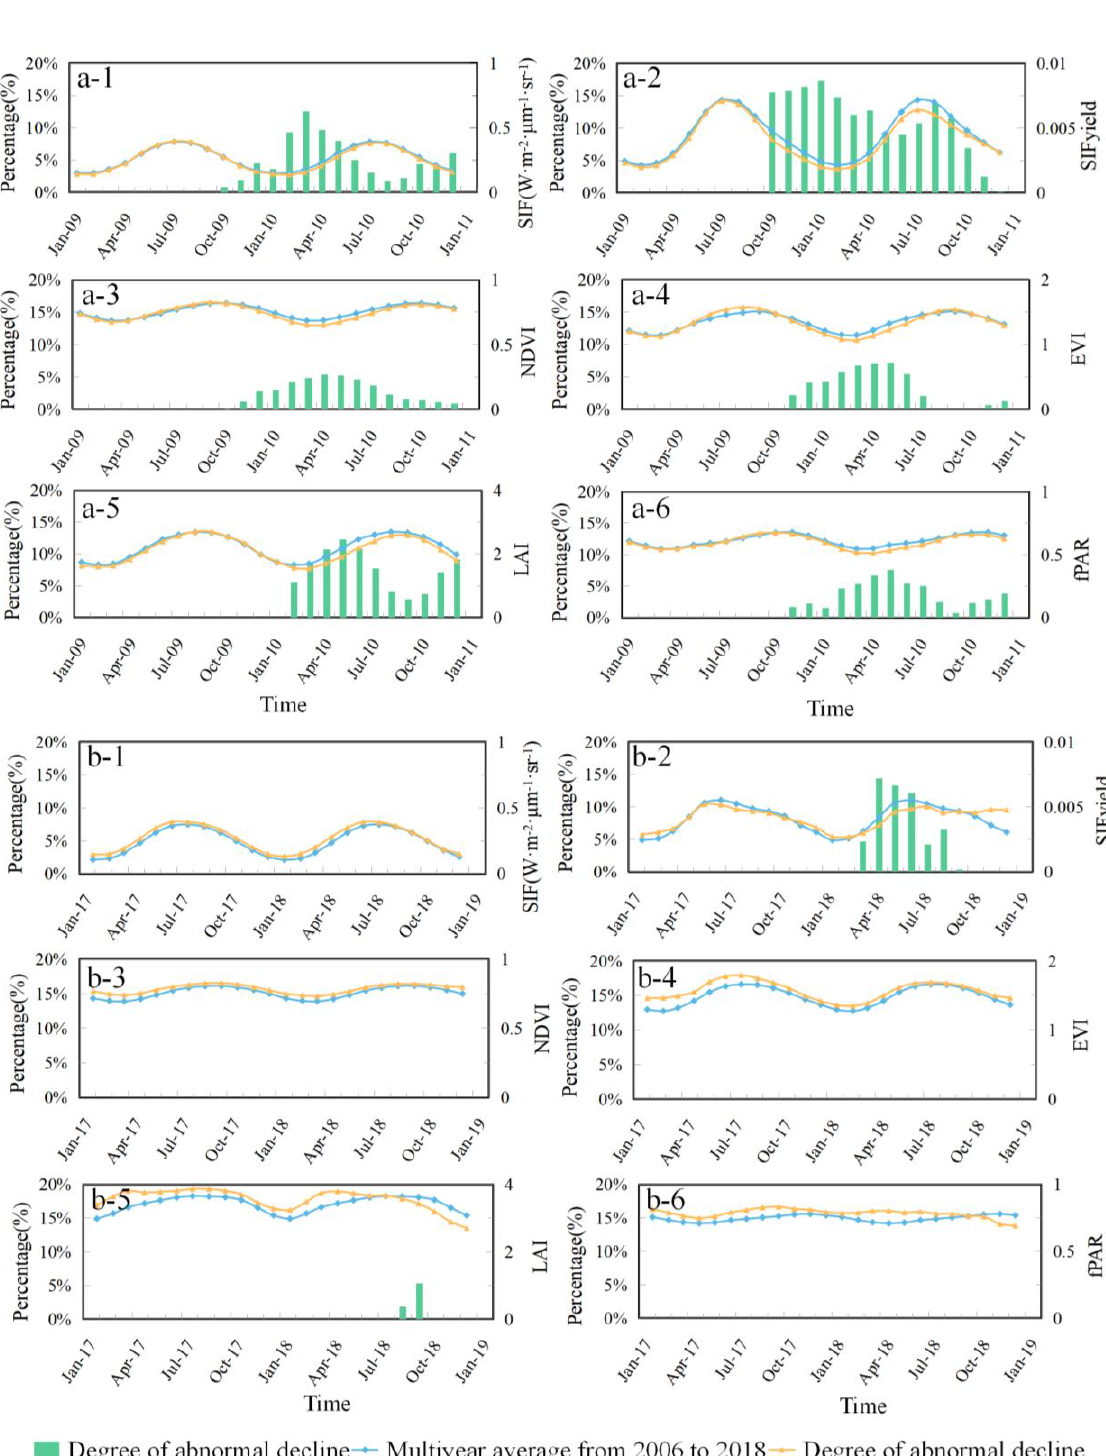
Figure 4. ( a1 – a6 ) The seasonal cycle variation curves of present values and multi-year averages and the abnormal decrease amplitude of the present values from the average values of SIF, SIFyield, NDVI, EVI, LAI, and fPAR, respectively, in Yunnan province ( b1 – b6 ). The seasonal cycle variation curves of present values and multi-year averages and the abnormal decrease amplitude of the present values from the average values of SIF, SIFyield, NDVI, EVI, LAI, and fPAR, respectively, in Fujian province.